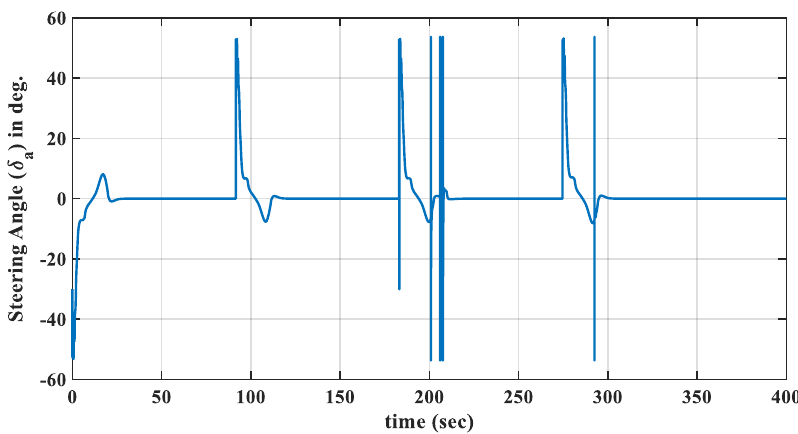
Figure 10. Steering angle using the non-optimized FLC.